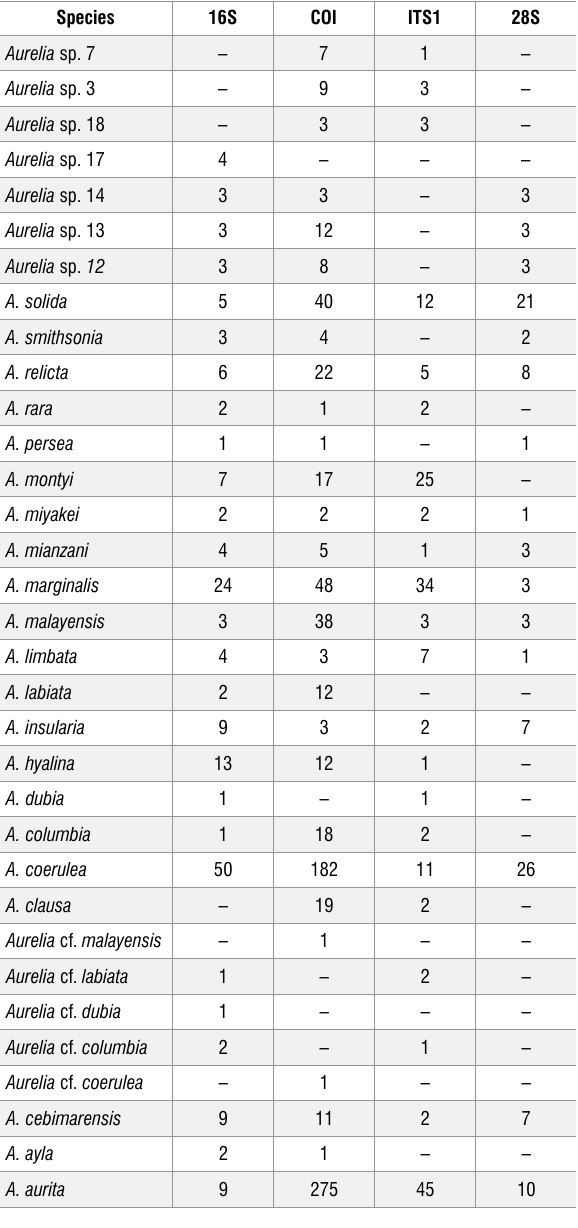
Table 1: Number of specimens of each gene region used for analyses in Lawley et al.